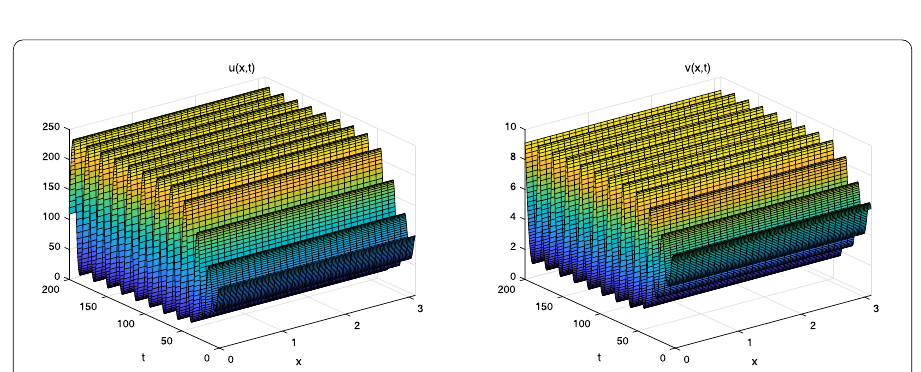
Figure 3 β = 0.3, d 1 = 1, d 2 = 0.3 and the initial condition is (99.568,5.787). The system produces periodic